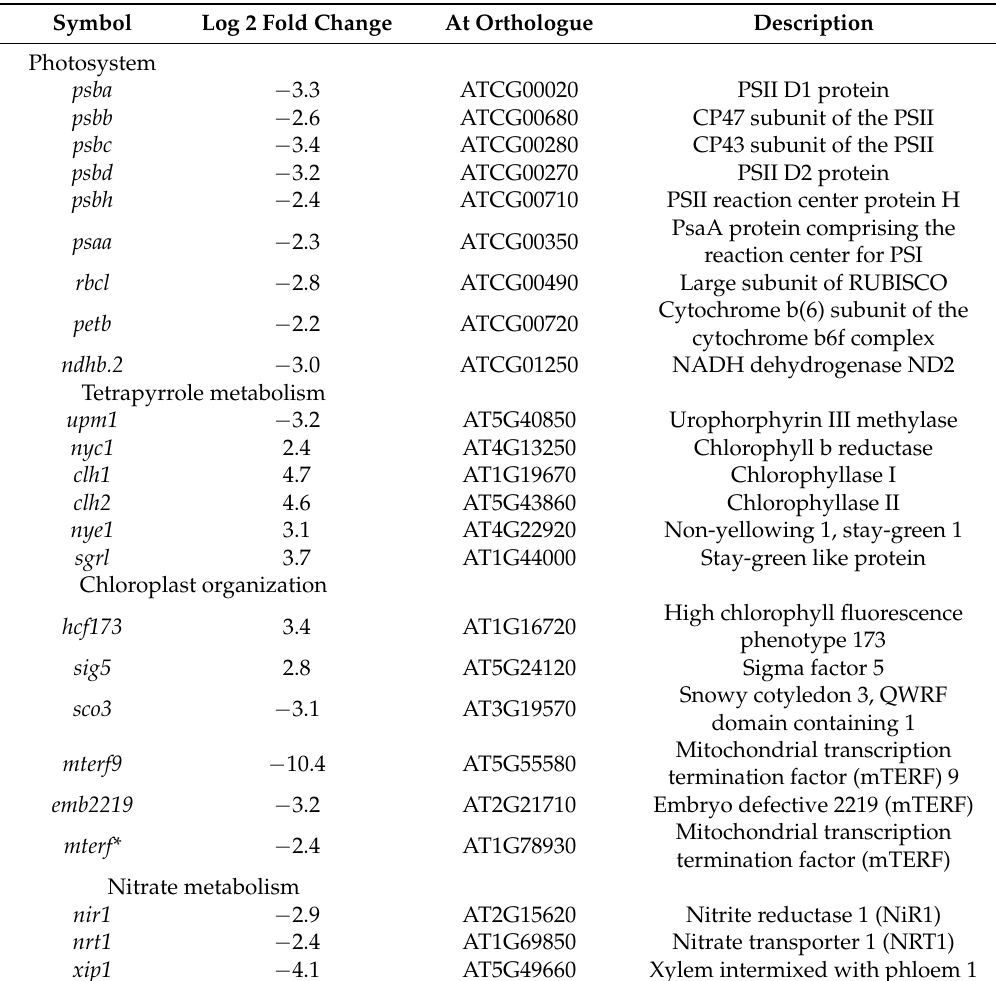
Table 2. List of DEGs related to photosynthesis and